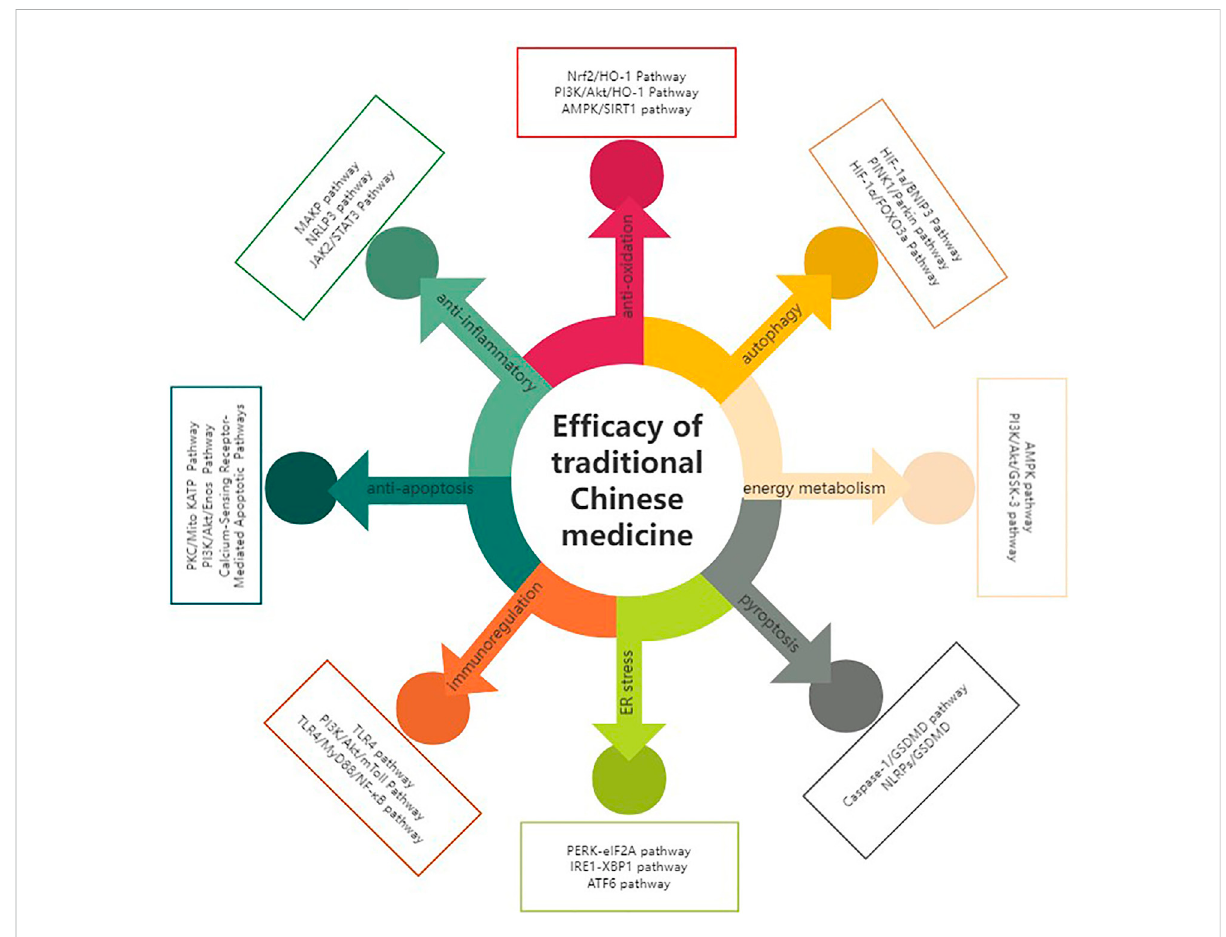
FIGURE 3 TCM anti-MIRI effects and their respective